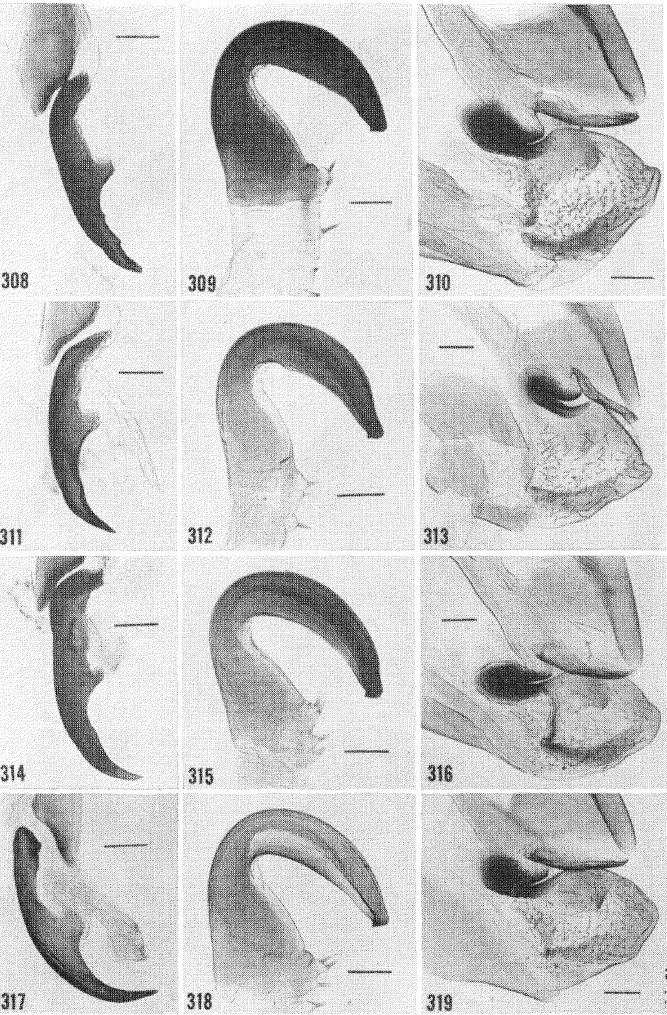
Figs. 308-319. Cockroach male genitalia. E1)ilampra sodalis. (all Para- types of Elilampra cinnamomea Hebard. St. Jean du Maroni, French Guiana. 308-310. (36 ANSP). 311-313. (93 ANSP). 314-316. (80 ANSP). 317-319. (91 ANSP). (scale 0.2